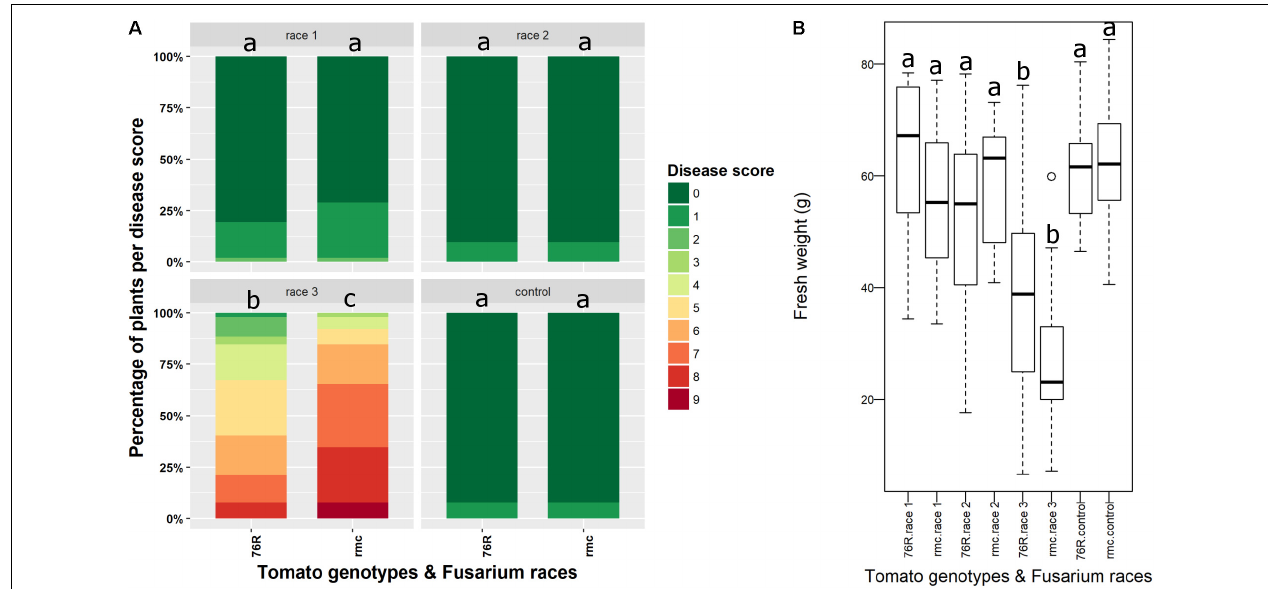
FIGURE 2 | Fusarium wilt disease assessment in rmc and 76R 6 weeks after inoculation with Fusarium oxysporum f. sp. lycopersici ( Fol ) race 1, race 2, and race 3. (A) Disease scoring of Fusarium wilt according to Fuchs et al. (1997) at 6 weeks after inoculation. The area for each color code indicates the percentage of plants having the corresponding disease scores. At least 10 plants of either rmc or 76R plant type in an individual pot were used in this assay. Control is non-inoculated plants treated only with water. Stacked bars followed by the same letter are not significantly different at the P < 0.05 level. (B) Box plot analysis showing that fresh weight of rmc plants inoculated with Fol race 3 is lower than 76R inoculated with Fol race 3 although the difference is not significant ( P > 0.05). Box plots indicated by the same letters are not significantly different at the P < 0.05 level.